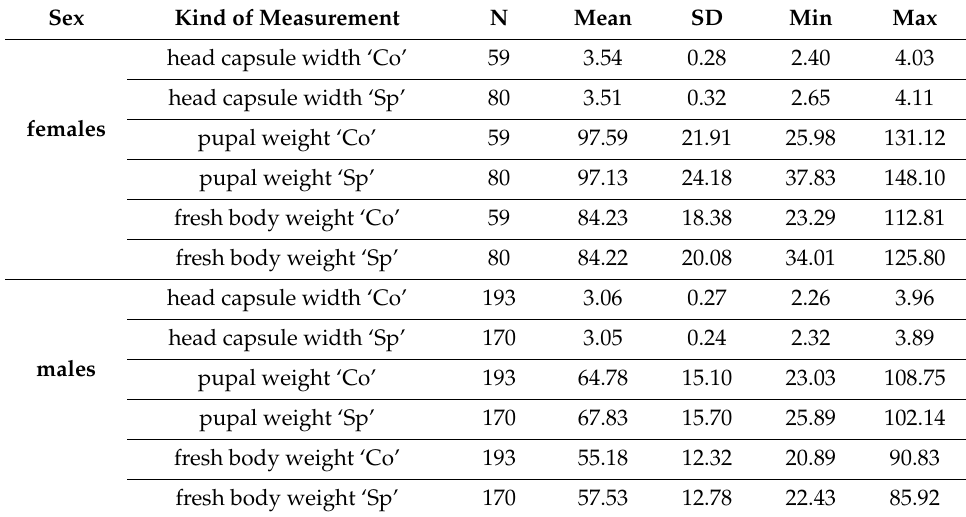
Table A3. Overview of measurements dependent on sex within the pharate dataset.